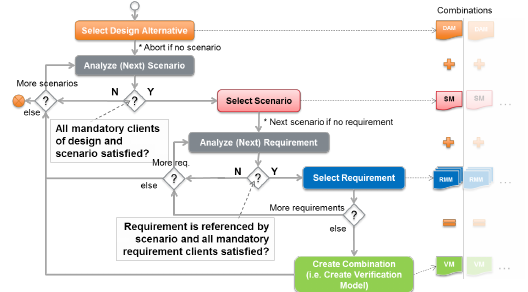
Figure 9: : Illustration of the verification models gen- eration